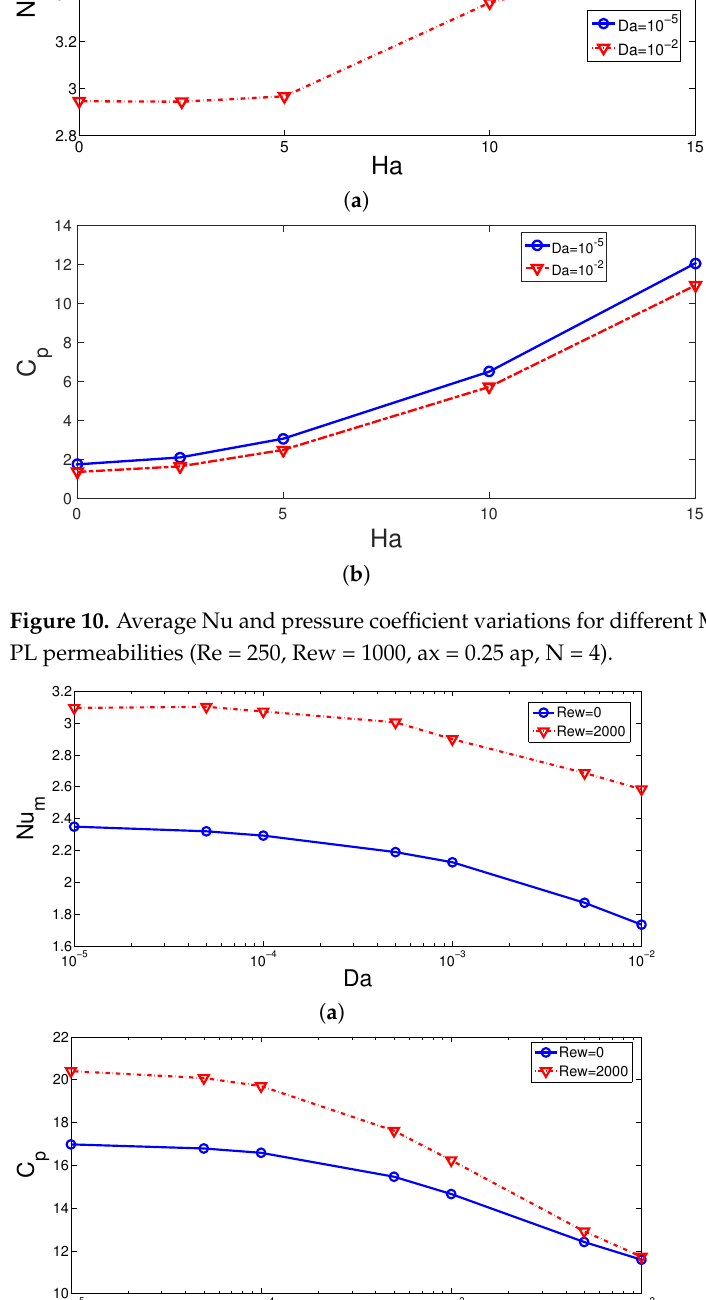
Figure 11. Effects of PL permeability on the variation of average Nu ( a ) and pressure coefficient ( b ) for stationary and rotating surface (Re = 250, Ha = 7.5, ax = 0.25ap, N = 4). The PL is a wavy one with rectangular type corrugation. The corrugation height is denoted by ax, while the number of corrugation waves is denoted by N. Corrugation wave amplitude effects on the flow pattern variations are shown in Figure 12 for